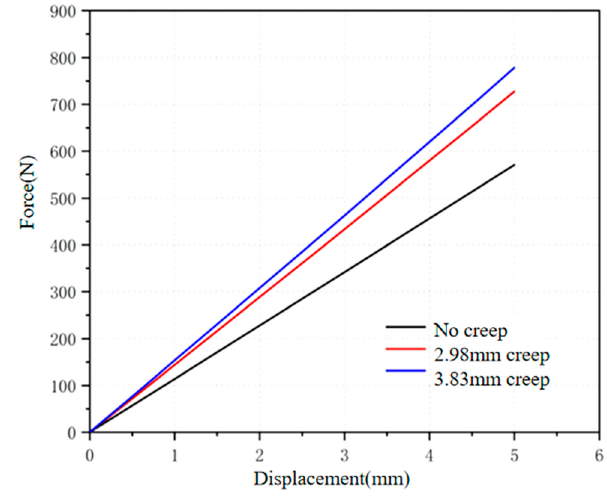
Figure 9. Static stiffness of suspension main spring under different creep conditions.